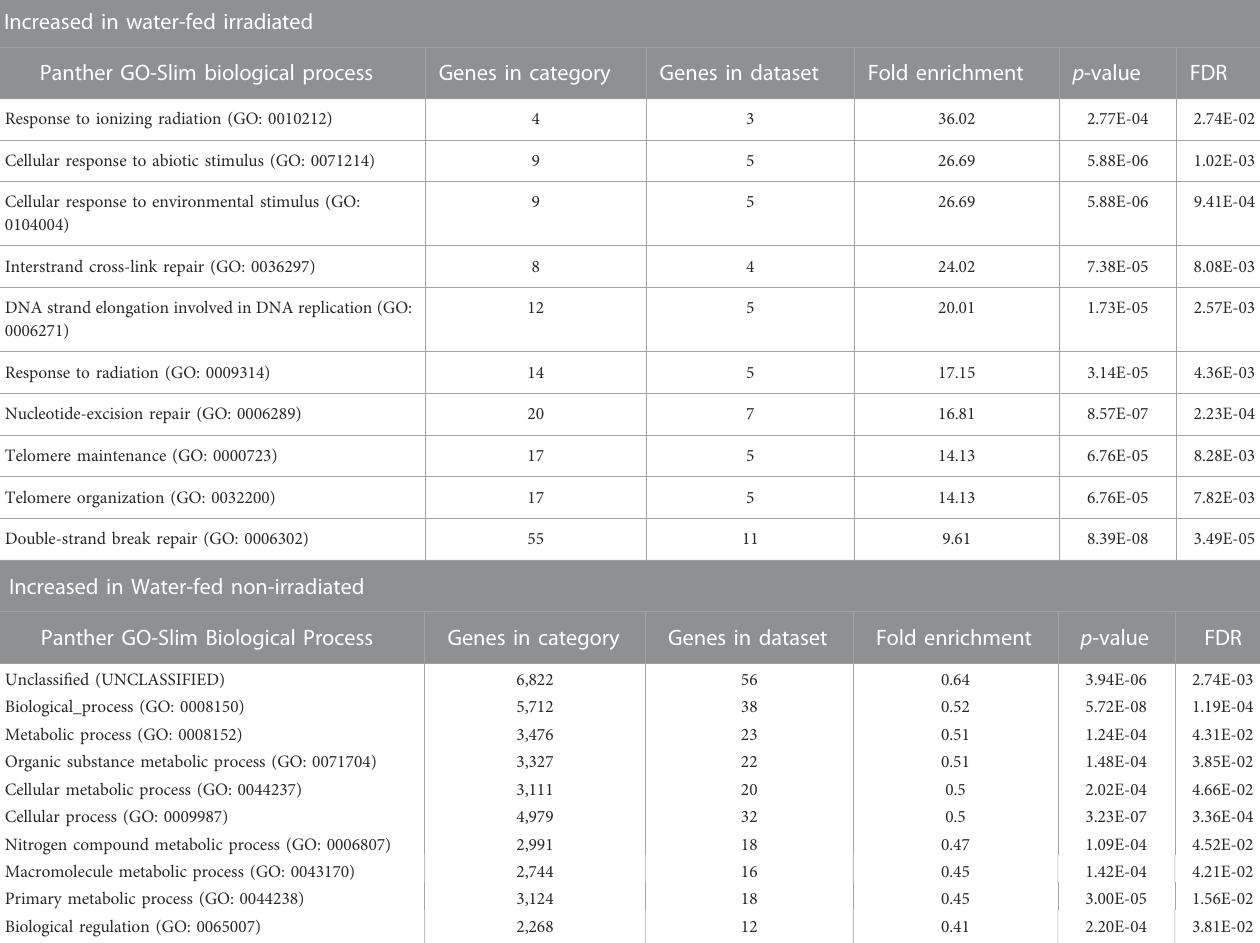
TABLE 2 Top ten gene ontology (GO) biological process terms identi fi ed in differentially expressed genes between water-fed non-irradiated and irradiated male Ae. aegypti . Gene ontology terms represent both parent and child terms enriched with genes either upregulated in irradiated mosquitoes relative to non-irradiated mosquitoes or upregulated in non-irradiated mosquitoes relative to irradiated mosquitoes. Increased in water-fed